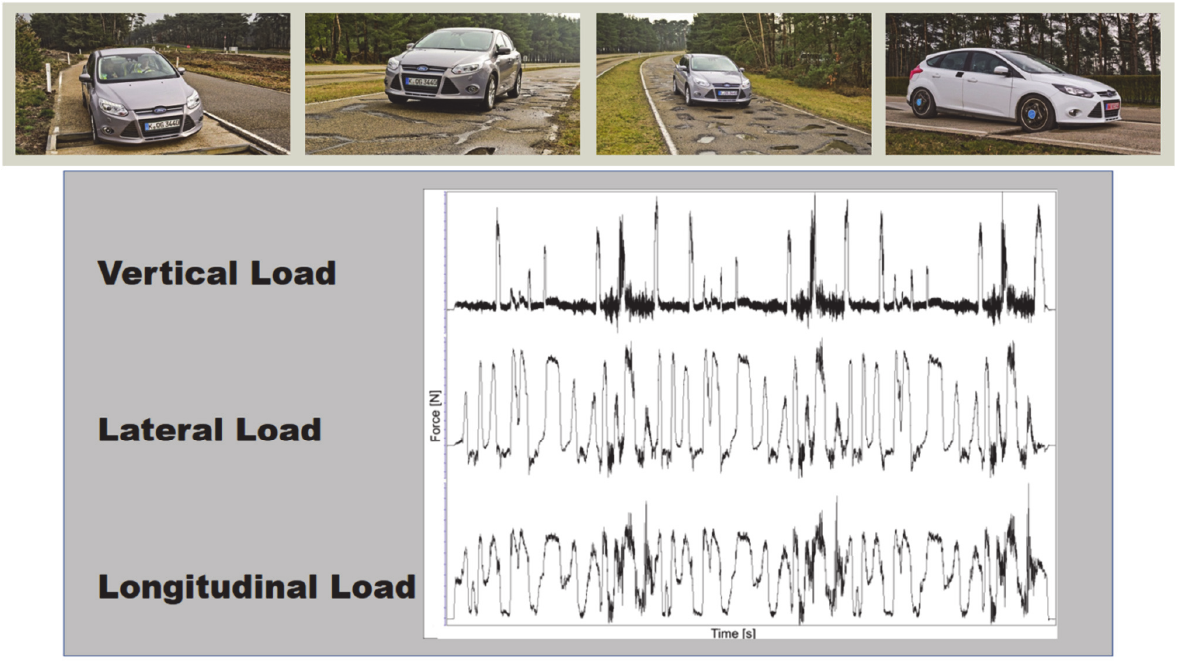
Figure 2. Variable Amplitude example in automotive application. Many different load events, many loads – shown here is just a short sequence of the wheel forces at one